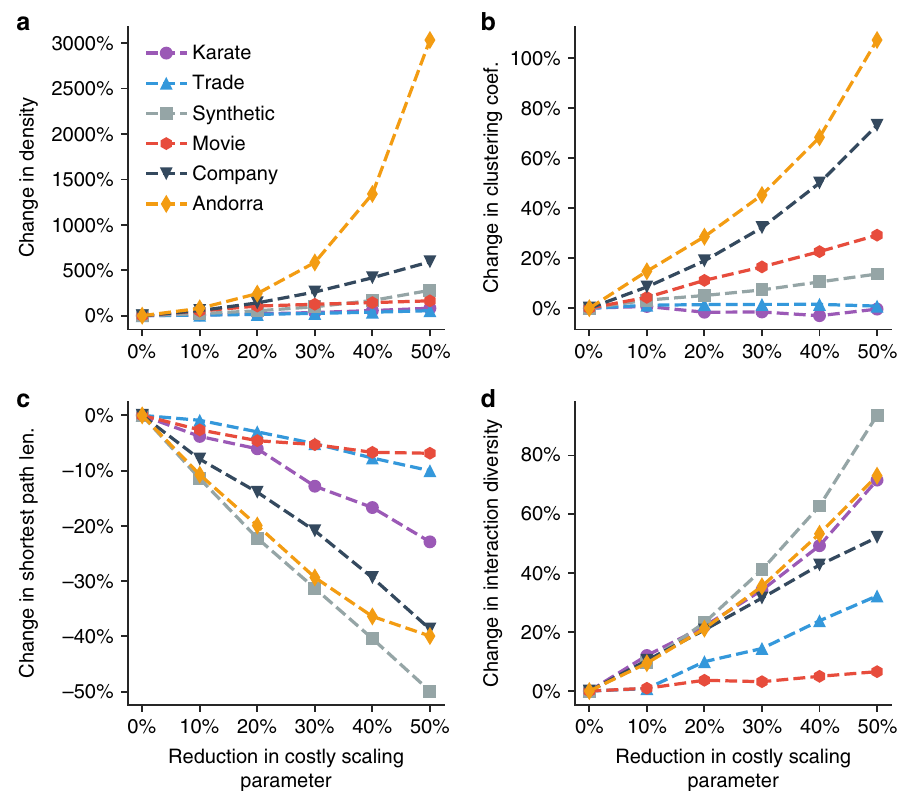
Fig. 4 Impact of reduction in costly scaling parameters on macro-level network statistics. a Density. b Clustering coef fi cient. c Average of shortest path lengths. d Interaction diversity. X -axis represents the reduction of costly scaling parameters; y -axis represents the dynamics of the macro-level network statistics when costly scaling parameters are